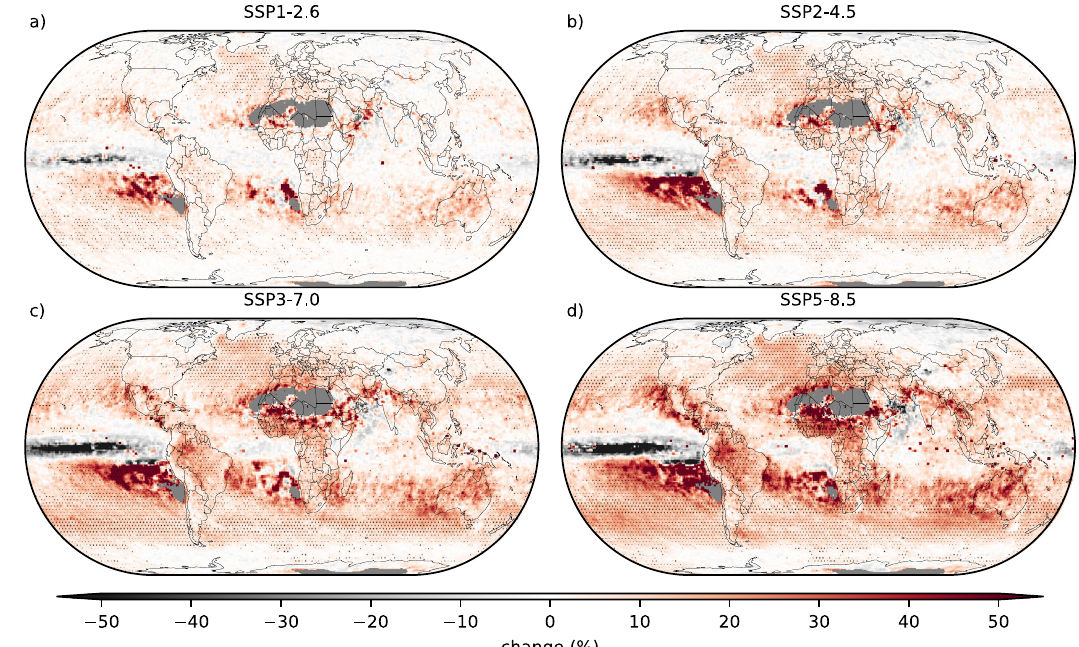
Fig. 4 Difference in future changes between rare and common extremes. Difference in weighted mean change for the 100- and 1-year return